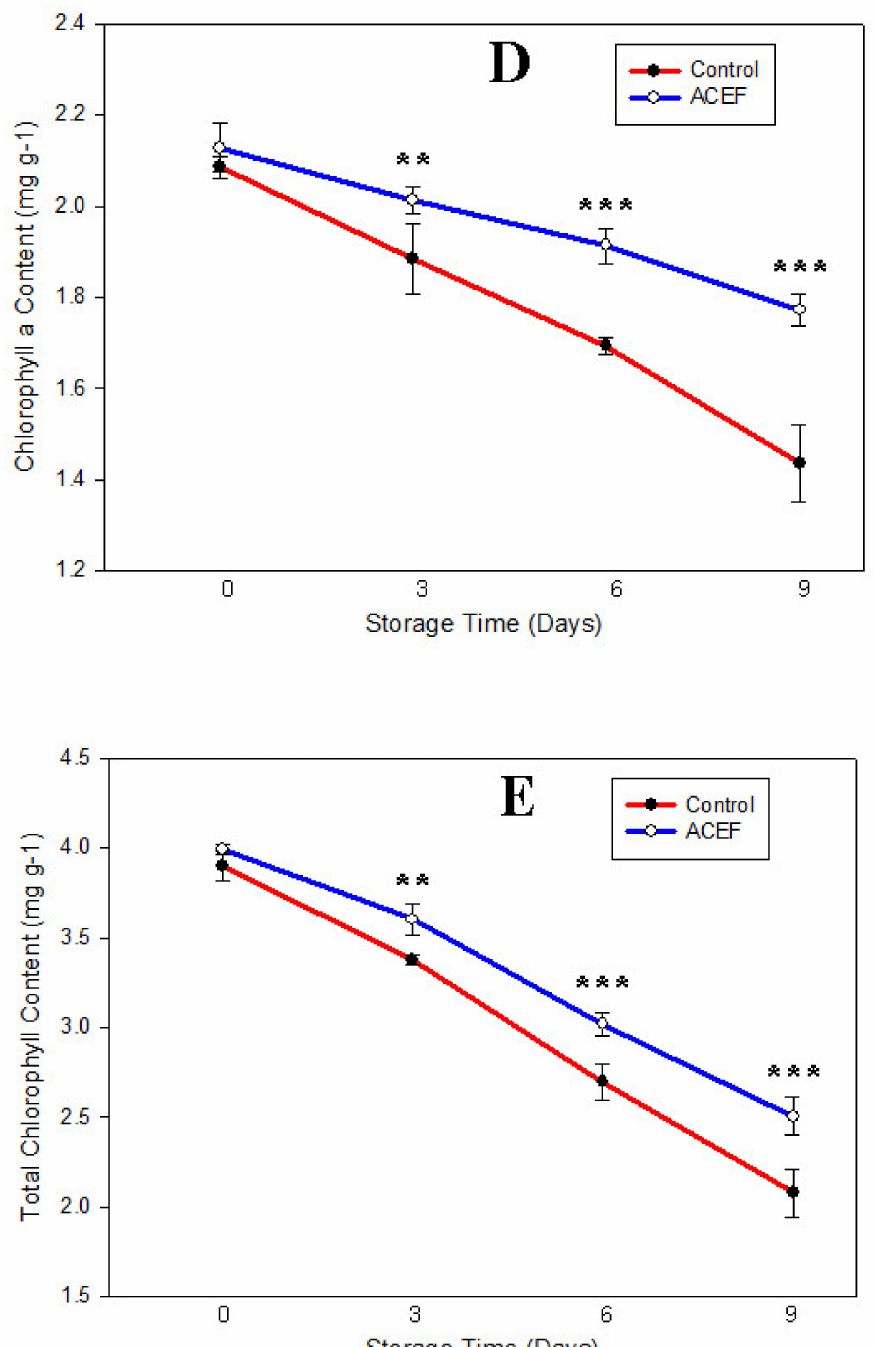
Figure 6. Effect of alternating current electric field (ACEF) on physicochemical quality of seagrape in spring during post-harvest storage ( A ) water loss ( B ) MDA ( C ) TPC ( D ) chlorophyll a content ( E ) total chlorophyll content. The data express means ( n = 3) with the error bar shows standard deviation. The star marks express the significant differences as respectively * ( p < 0.1), ** ( p < 0.05), and *** ( p <